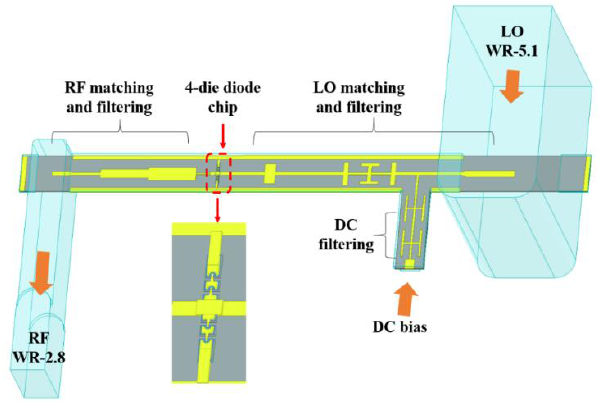
Figure 4. Circuit configuration of the proposed 0.34 THz tripler in HFSS.